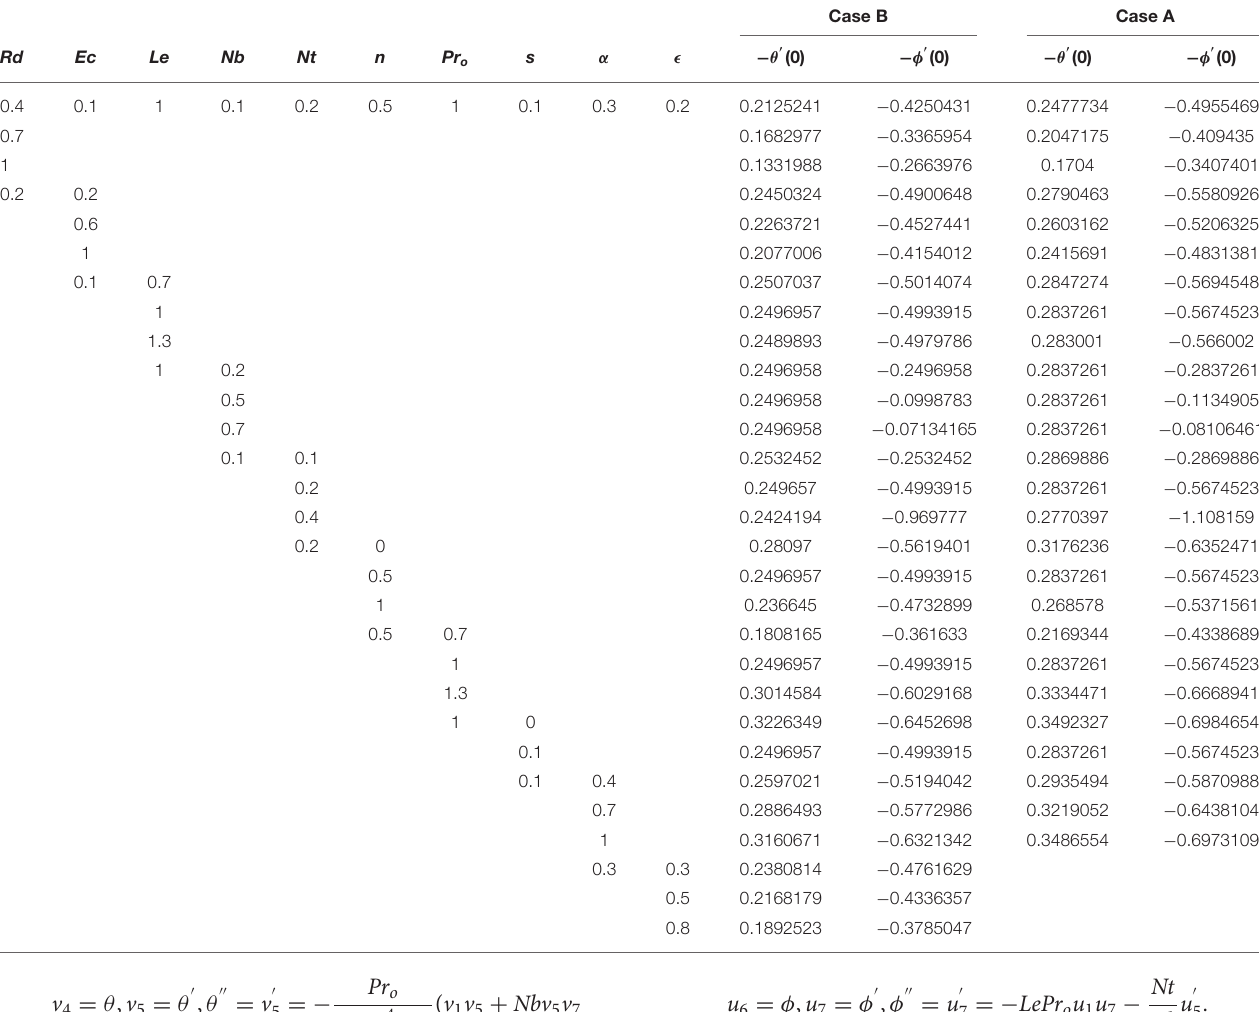
TABLE 3 | Comparison of the values of − θ ′ (0) and φ ′ (0) for different values of Rd , Ec , Le , Nb , Nt , n , Pr o , s , α , and ǫ for Case B with Case A,